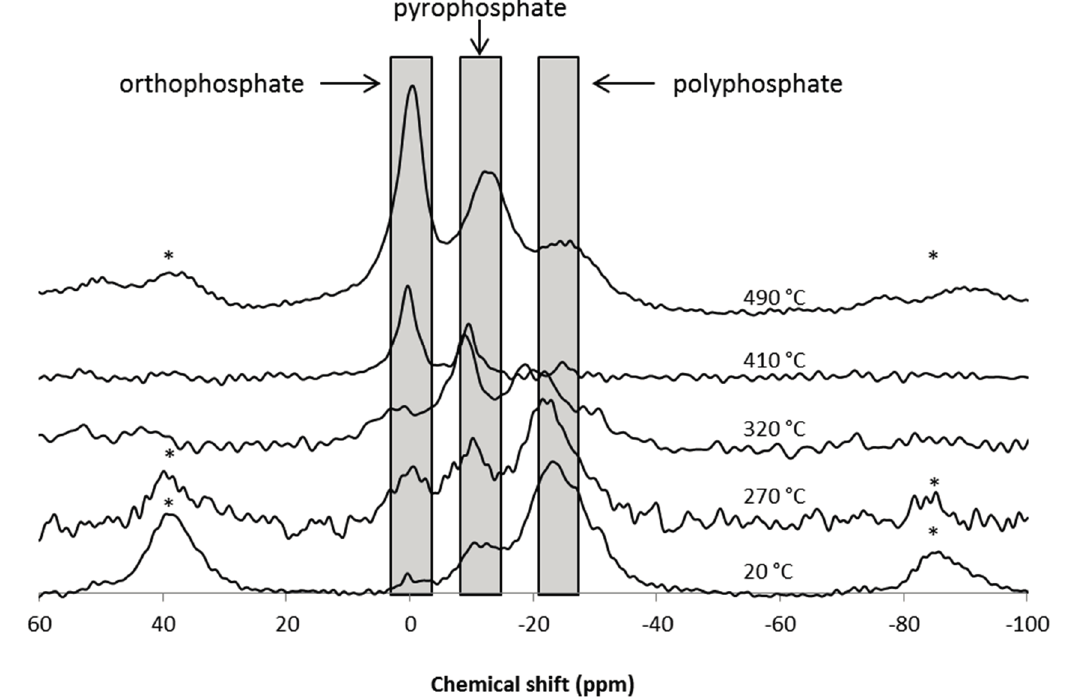
Figure 9. 31 P CP-HPDEC-MAS NMR spectra of the PA6/GAS 2.5%/MPP2.5% residues obtained after thermal treatment at 20, 270, 320, 410 and 490 °C (* spinning